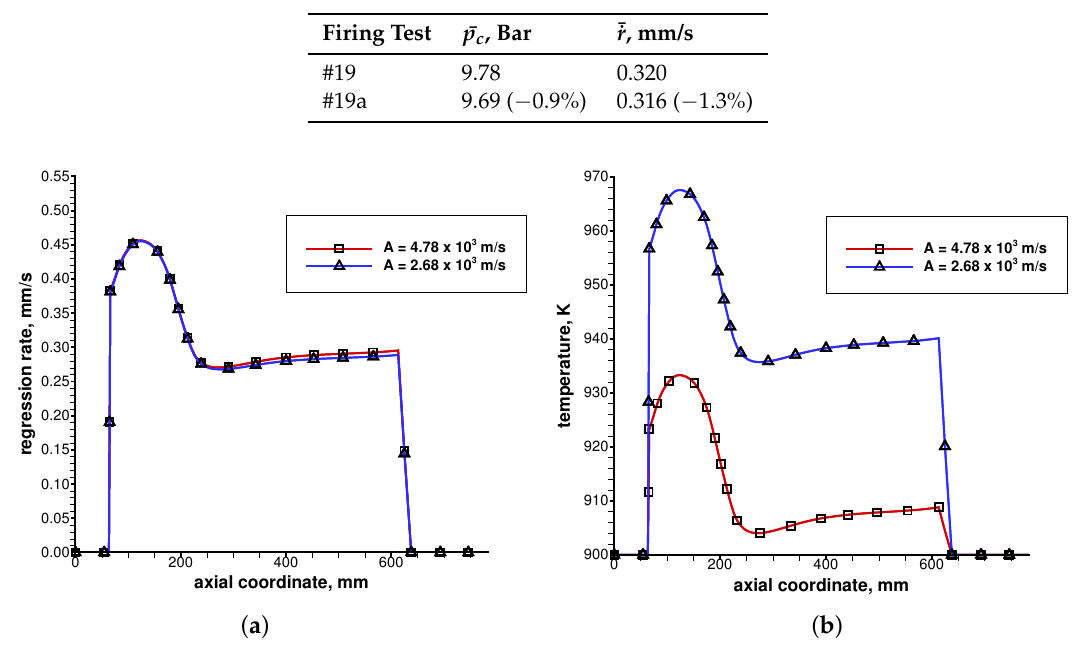
Figure 5. Effect of the pre-exponential constant on the fuel regression rate and the fuel temperature: ( a ) fuel regression rate; ( b ) fuel